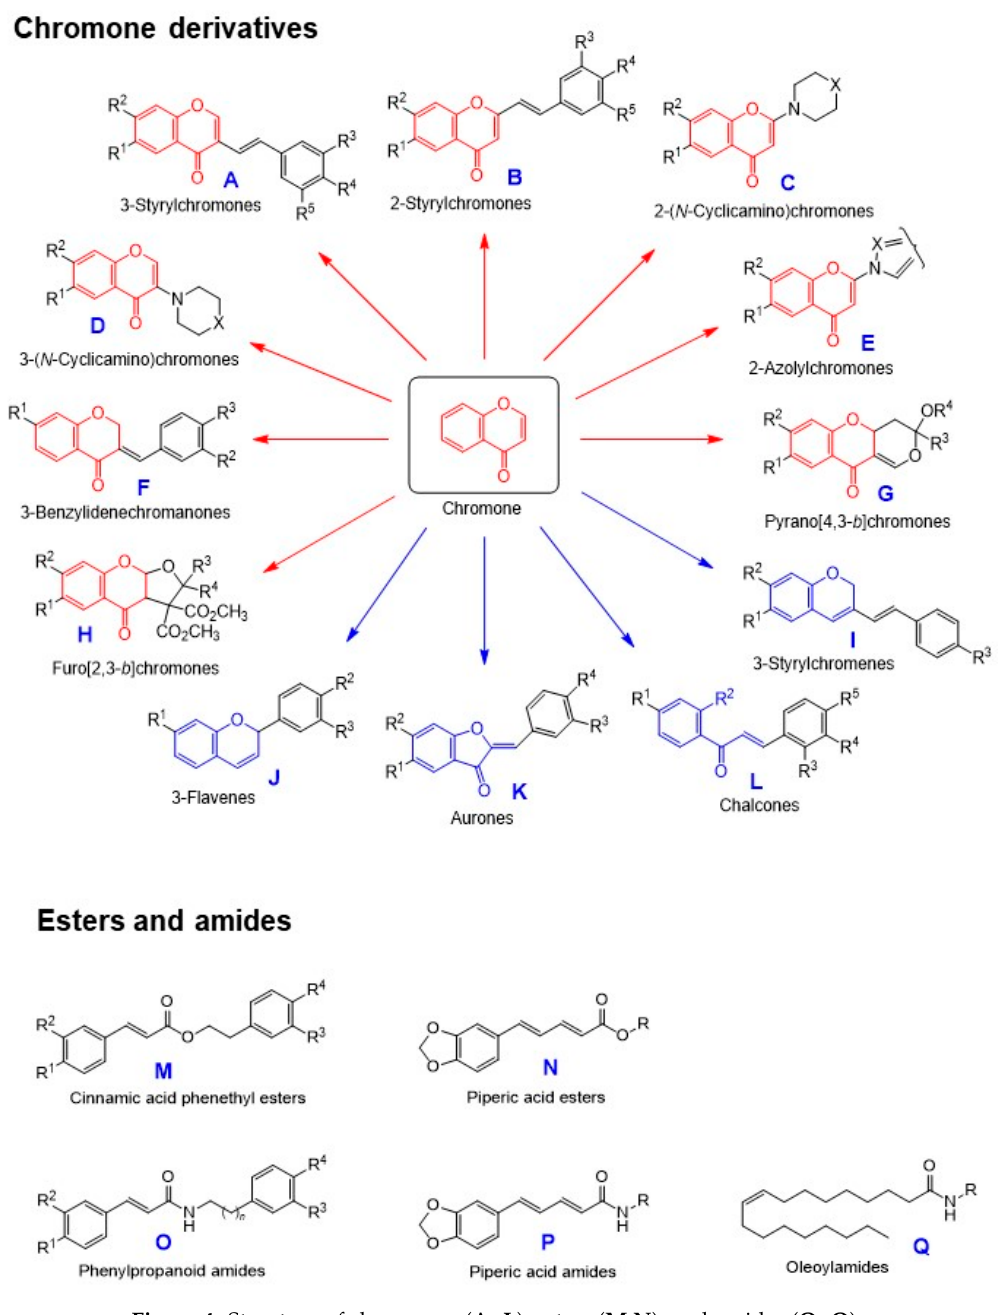
Figure 4. Structure of chromones ( A ~ L ), esters ( M , N ), and amides ( O ~ Q ).